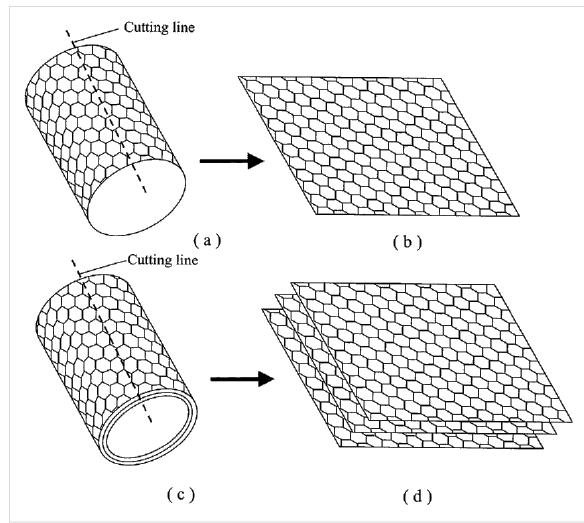
Figure 3: (a) SWNT, (b) cut and flattened SWNT consisting of single- layer graphene (SLG), (c) MWNT, and (d) cut and flattened MWNT consisting of multi-layer graphene (MLG). Source: